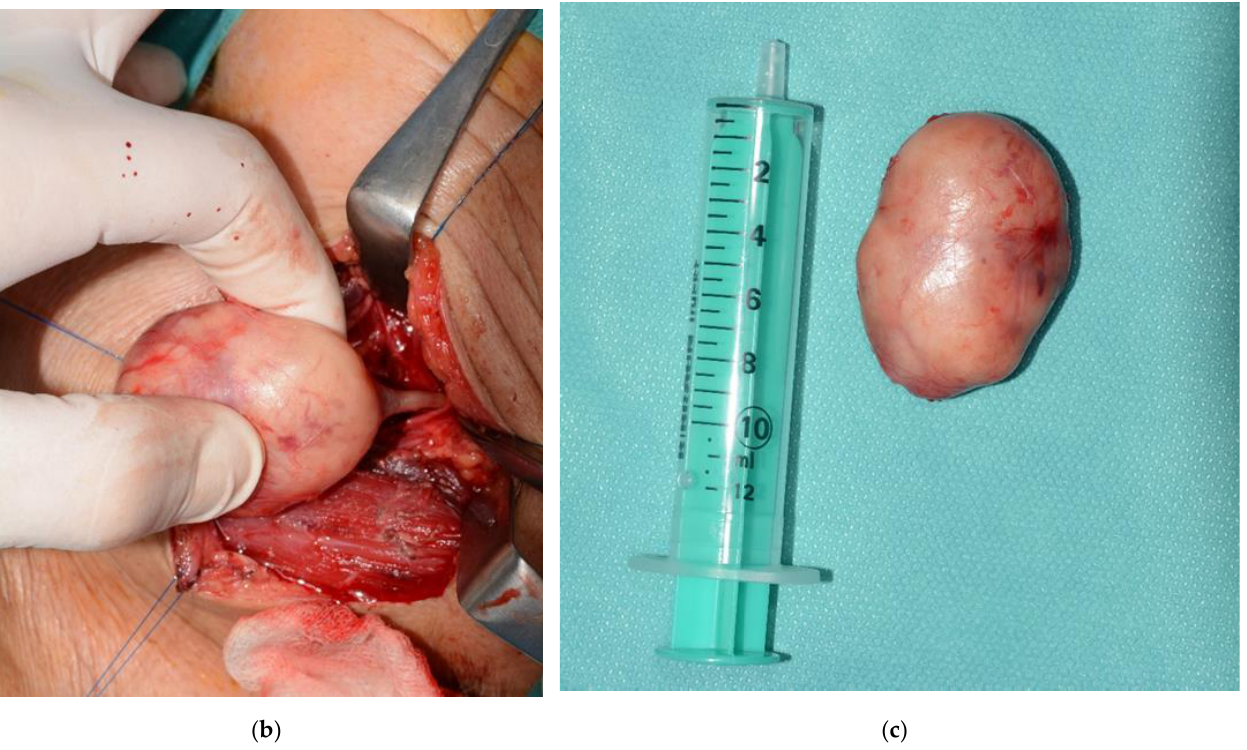
Figure 5. The well-incapsulated mass was micro surgically dissected from the superior laryngeal nerve ( a ). Several neural fascicles remain attached ( b ), and an “in-block” resection vas done; ( c ) the aspect of the tumoral mass upon its removal.